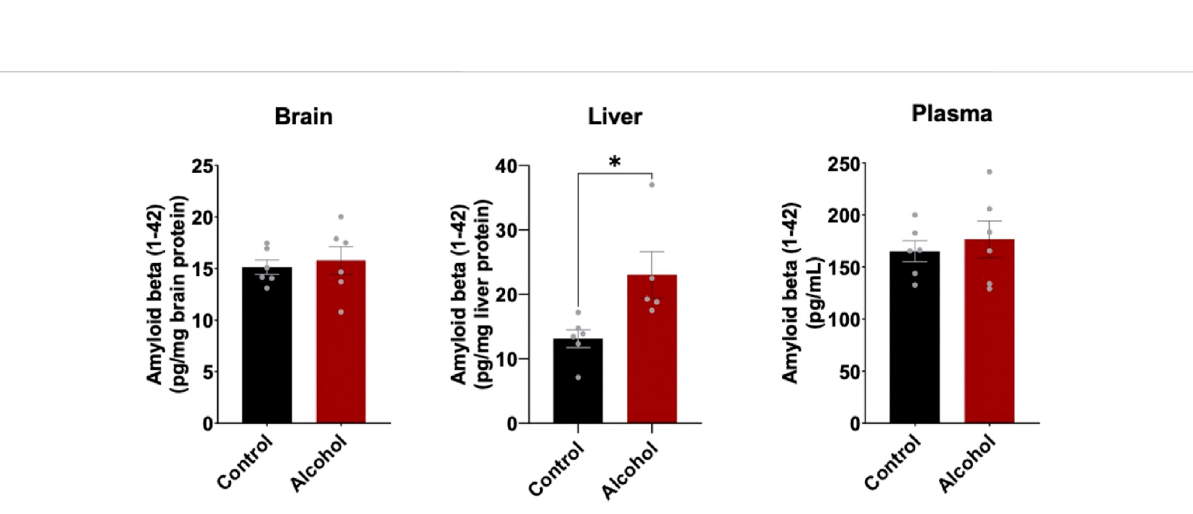
Mouse A β (1 – 42)levelsinthebrain, plasma, andliver following 4 weeks ofintragastricalcohol feedingto mice.LevelsofmouseA β (1 – 42) in brain and liver homogenate supernatants, as well as plasma samples were determined using ELISA. Results are mean ± SD. n = 6 – 7 mice. * p < 0.05 vs.